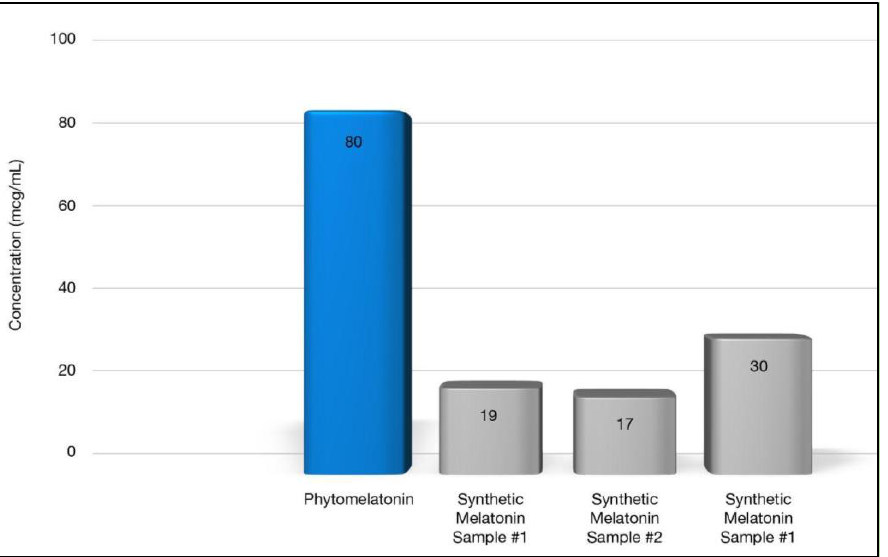
Figure 4. Free Radical Scavenging Percentage (DPPH%) by phytomelatonin (blue bar) and three synthetic melatonins (gray bars). Data are expressed as mcg/mL. Values are derived from the original data presented in [34].